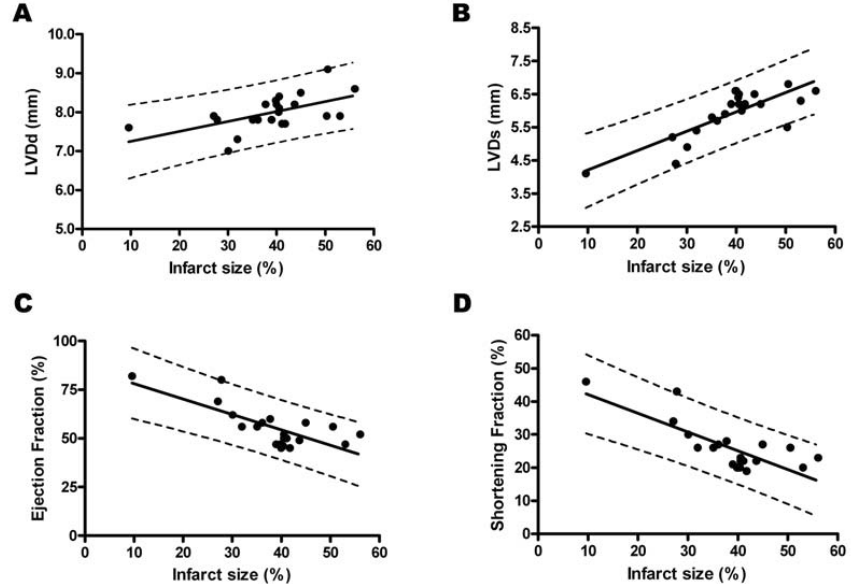
Fig. 2 – A. Correlation between infarct size and left ventricular diastolic diameter (LVDd) measured at 7 days post-surgery. R = 0.59, p < 0.05, N = 22. B. Correlation between infarct size and left ventricular systolic diameter (LVDs) measured at 7 days post-surgery. R = 0.71, p < 0.001, N = 22. C. Correlation between infarct size and ejection fraction (%) measured by M-Mode at 7 days post-surgery. R = –0.57, p = 0.003, N = 21. D. Correlation between infarct size and shortening fraction (%) measured by M-Mode at 7 days post-surgery. R = –0.59, p = 0.004, N = 21. Doted lines delimit 95 % confidence